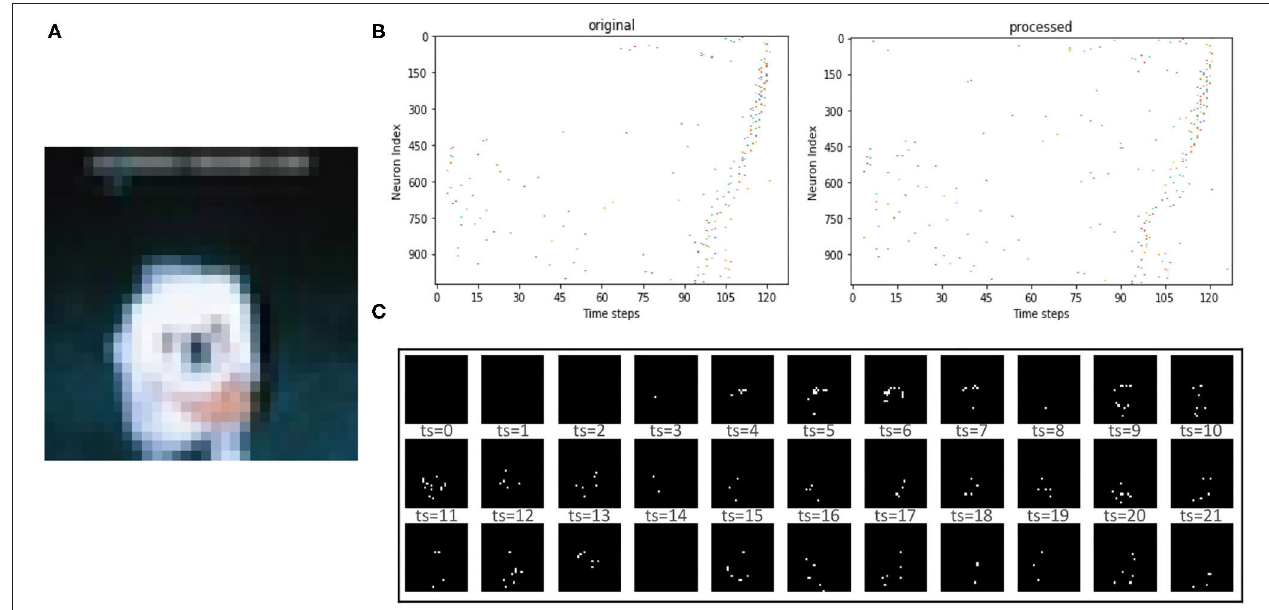
FIGURE 5 | (A) The original image input to the SNN. (B) The orignial spike train input to the neurons and the processed version generated by neurons. (C) The reconstructed image at the first 33 time steps after time-based coding.